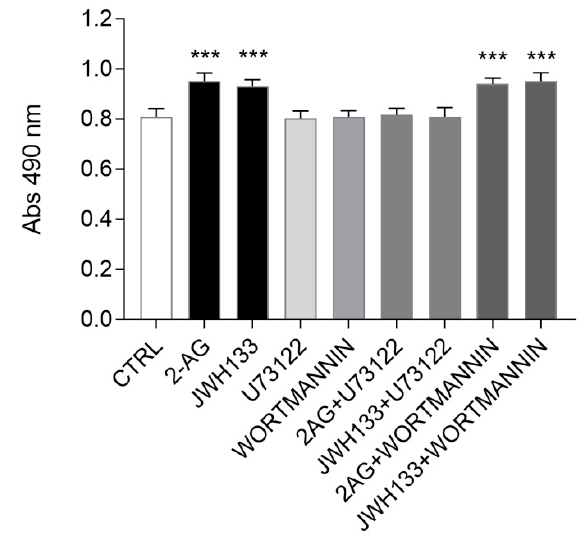
Figure 5. Evaluation of Phospholipase C (PLC) and PI3K pharmacological blockade on 2-AG- and JWH133-induced ST14A cell number increase. Cells were pretreated 30 min with U73122 (2 µM) or wortmannin (150 nM) prior to 2-AG (5 µM) or JWH133 (300 nM) incubation for 24 h in 2% serum- containing medium. U73122, but not wortmannin pretreatment, reverted 2-AG- and JWH133-driven ST14A cell number increase. Data from MTS assay are expressed as means ± standard deviation (SD) of the absorbance ( λ = 490 nm); n = 8 replicates, 3 independent experiments. *** = p ≤ 0.001 vs. control.